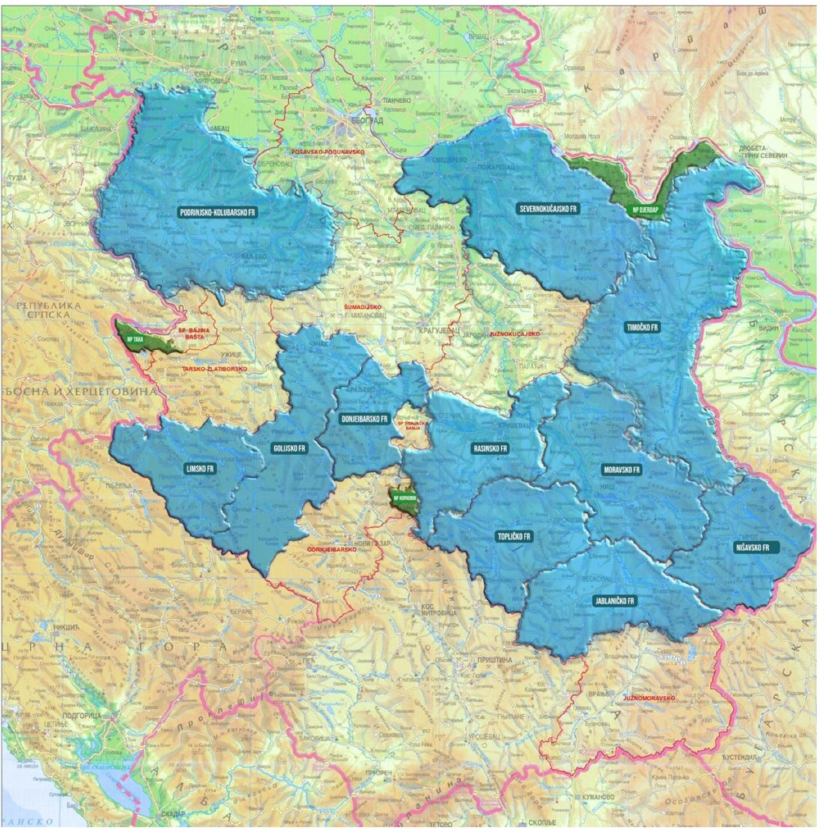
Figure 1. Map of the research